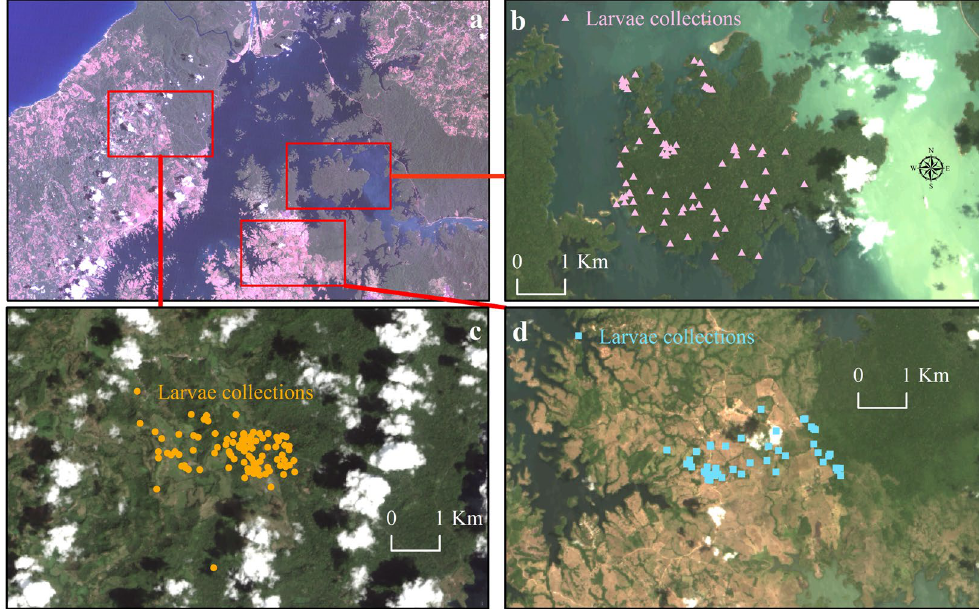
Figure 4. ( a ) The lowland tropical rainforest of Central Panama, 2000. ( b ) The Barro Colorado Island, 2014. ( c ) Achiote, 2016. ( d ) Las Pavas, 2014. Source: Landsat imagery courtesy of NASA Goddard Space Flight Center and U.S. Geological